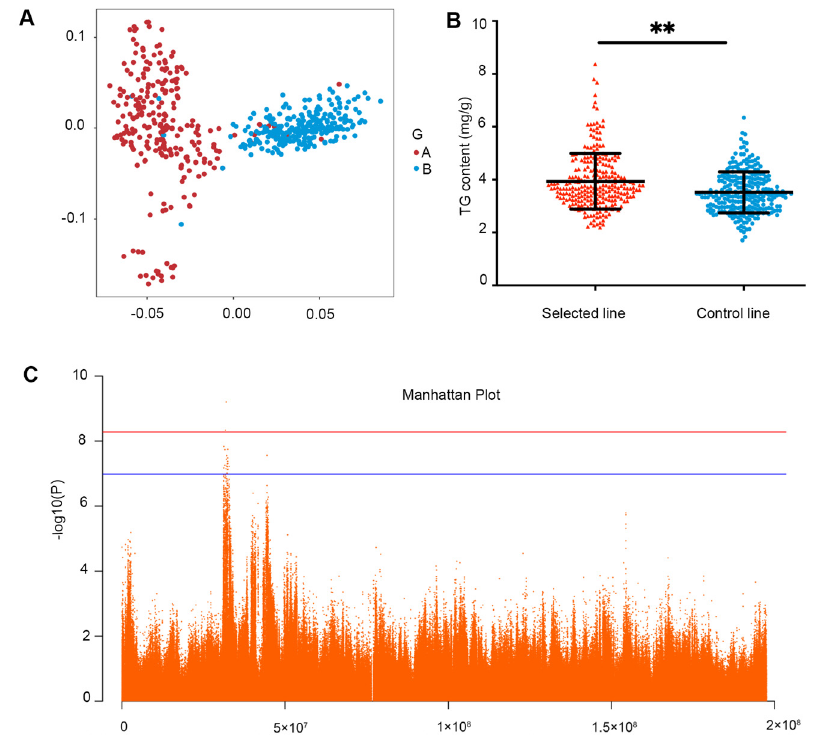
Figure 1. The GWAS result of TG content in the breast muscle tissue of Jingxing-yellow (JXY) chickens. ( A ) The principal component analysis (PCA) of the population structure of the selected and the control lines (A stands for the selected line, B stands for the control line). ( B ) TG content of the selected line and the control line (**, p < 0.01). ( C ) Genome-wide association analysis of significant regions for TG traits. The red and blue lines indicate the Bonferroni-corrected thresholds of genome-wide and suggestive significances, respectively.